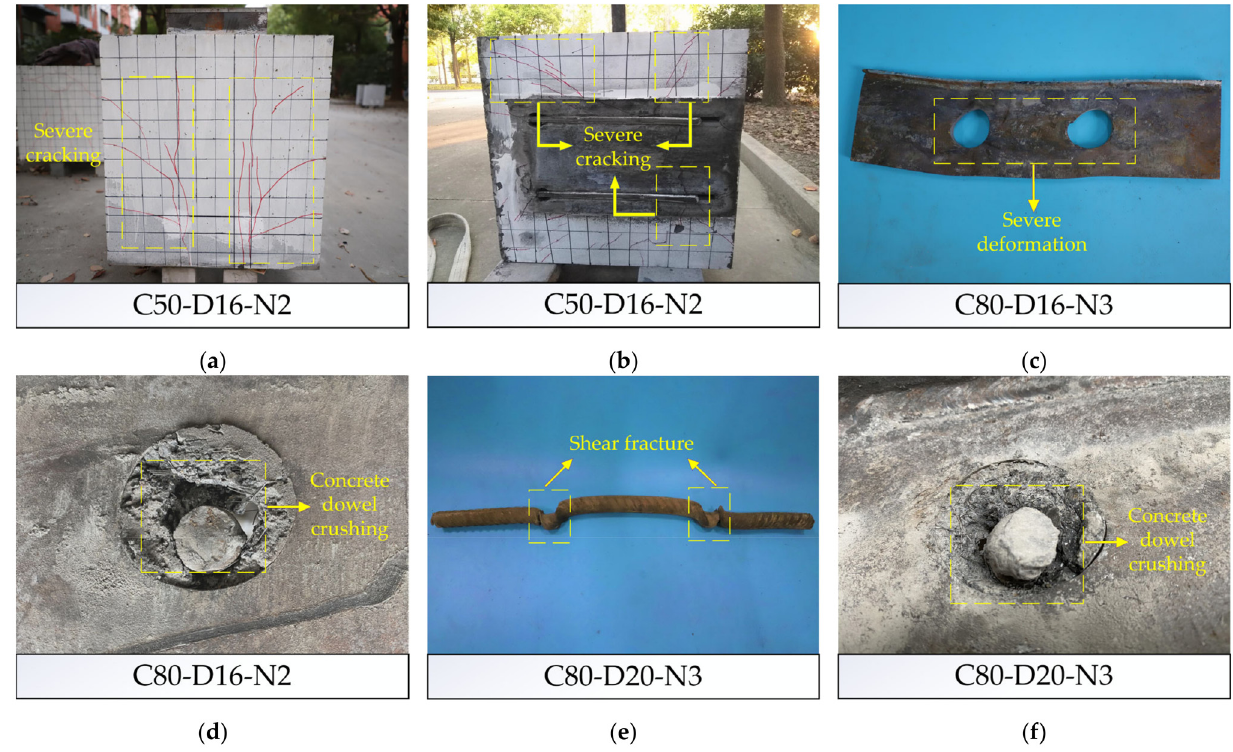
Figure 4. Typical failure modes of PBL connectors: ( a ) outside of concrete slab; ( b ) inside of concrete slab; ( c ) perforated steel plate; ( d ) concrete dowel; ( e ) penetrating rebar; ( f ) concrete